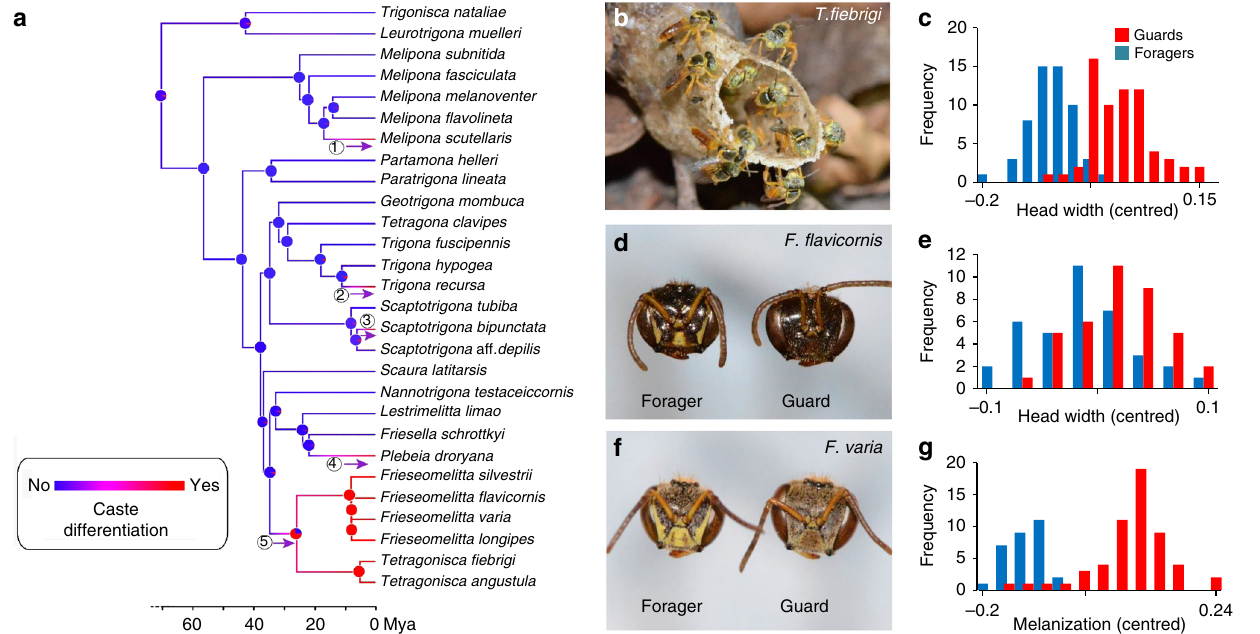
Fig. 1 Comparison of guards and foragers in 28 species of stingless bees. a Phylogenetic reconstruction based on a previously published phylogeny 18 . The color gradient from blue to red indicates the probability that a species evolved increased guard size, based on 1,000 simulations using a Bayesian framework. Numbers 1 – 5 indicate independent appearances of increased guard size. b Tetragonisca fi ebrigi guards standing on the wax entrance tube (Photo: C. Grüter). c Size-frequency distribution of T. fi ebrigi foragers and guards showing a bimodal distribution. Values (unit = mm) are centred for each colony (colony mean and total mean = 0) to correct for overall colony differences ( N = 58 forager/65 guards/6 colonies). d Frieseomelitta fl avicornis guard and forager (Photo: C. Grüter). e Size-frequency distribution of F. fl avicornis foragers and guards, showing a unimodal distribution. Values (unit = mm) are centred for each colony ( N = 37/39/6). f Head of a Frieseomelitta varia forager and guard (Photo: C. Grüter). g Melanization frequency distribution of F. varia guards and foragers. Values (unit = melanization level, see methods) are centred for each colony ( N = 30/56/6)